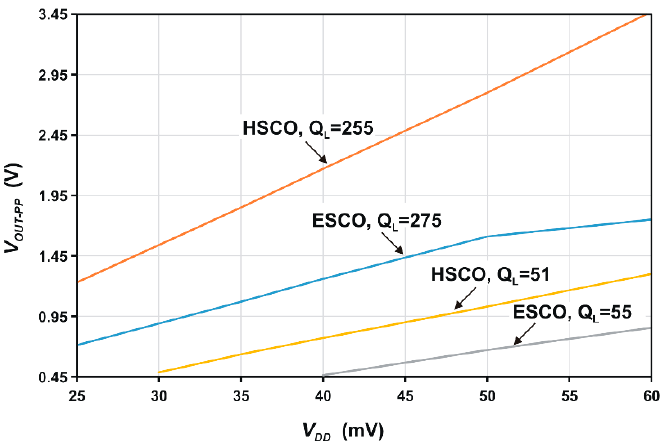
Figure 4. Peak ‐ to ‐ peak values of the output voltage, v OUT ‐ PP , as a function of the supply voltage, V DD , for HSCO and ESCO.